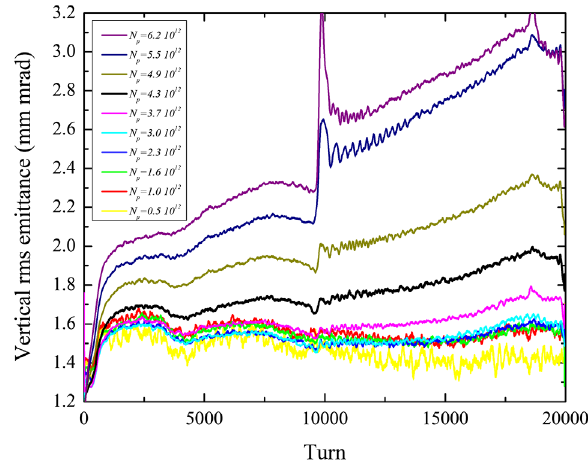
FIG. 13. Evolution of the IPM vertical emittance in the Booster cycle at different intensities N p from 0 . 5 × 10 12 (2 turns injection) to 6 . 2 × 10 12 (20 turns injection). All the data are smoothed by a 100 turn running window